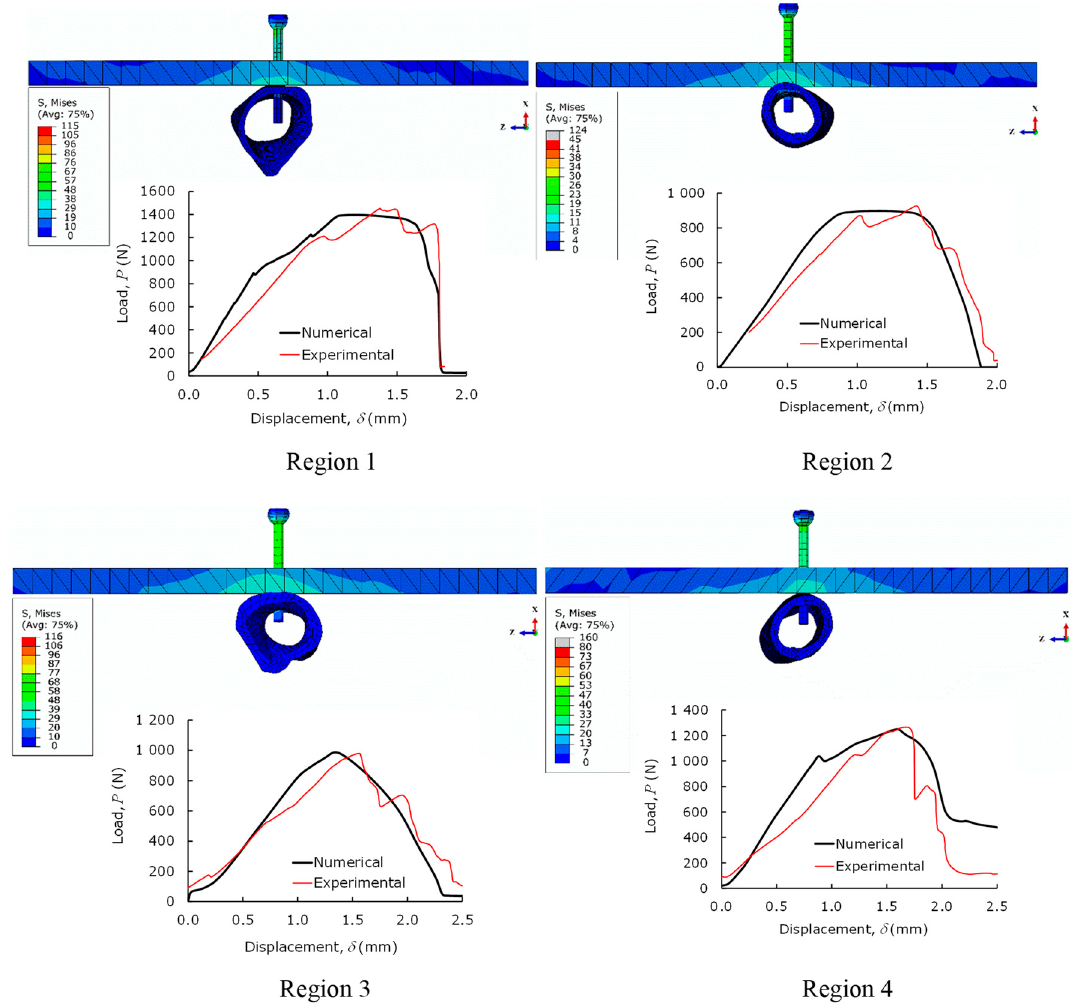
Figure 13. Numerical agreement of pull ‐ out tests for each region shown in Figure 8a. Table 2. Parameters of the cohesive mixed ‐ mode (I+II) law obtained in pull ‐ out tests.